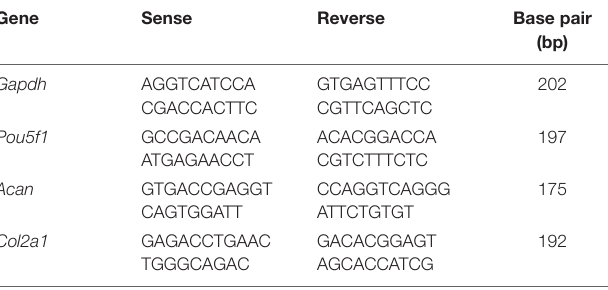
TABLE 1 | Oligonucleotide